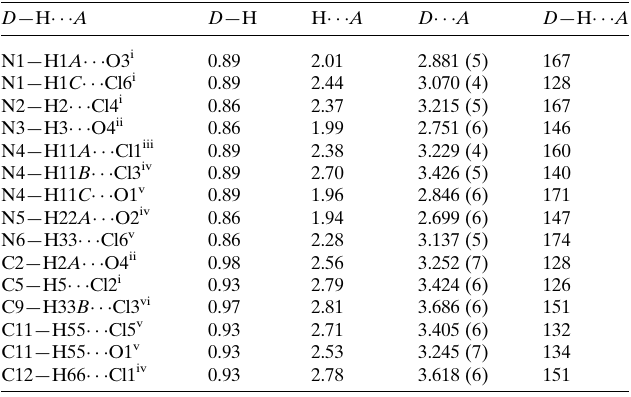
Table 1 Hydrogen-bond geometry (A˚ , (cid:4) ).